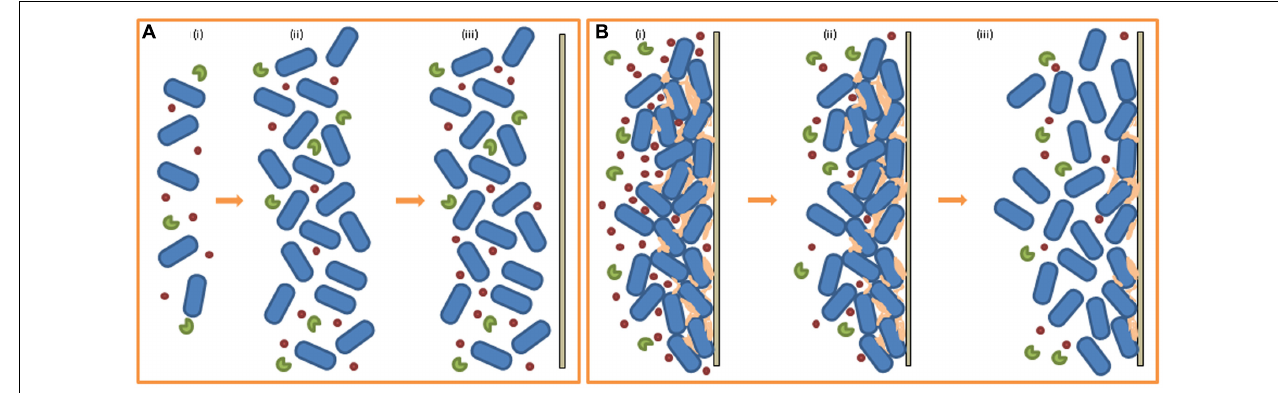
FIGURE 3 | Quorum quenching (QQ) and biofilm formation. (A) Effect of QQ molecules on early stage biofilm formation (i) low population density, low QS signal, addition of QQ molecules (ii) high population density, low QS signal, QS molecules degraded by QQs (iii) absence of attachment to solid surface, biofilm formation does not occur. (B) Effect of QQ molecules on early pre-existing biofilm (i) biofilm formed, high QS signal, addition of QQ molecules (ii) QS molecules degraded by QQs, reduction of QS signal (iii) decrease in EPS production, release of cells, return of released cells to planktonic state (i.e., reduced biofilm).